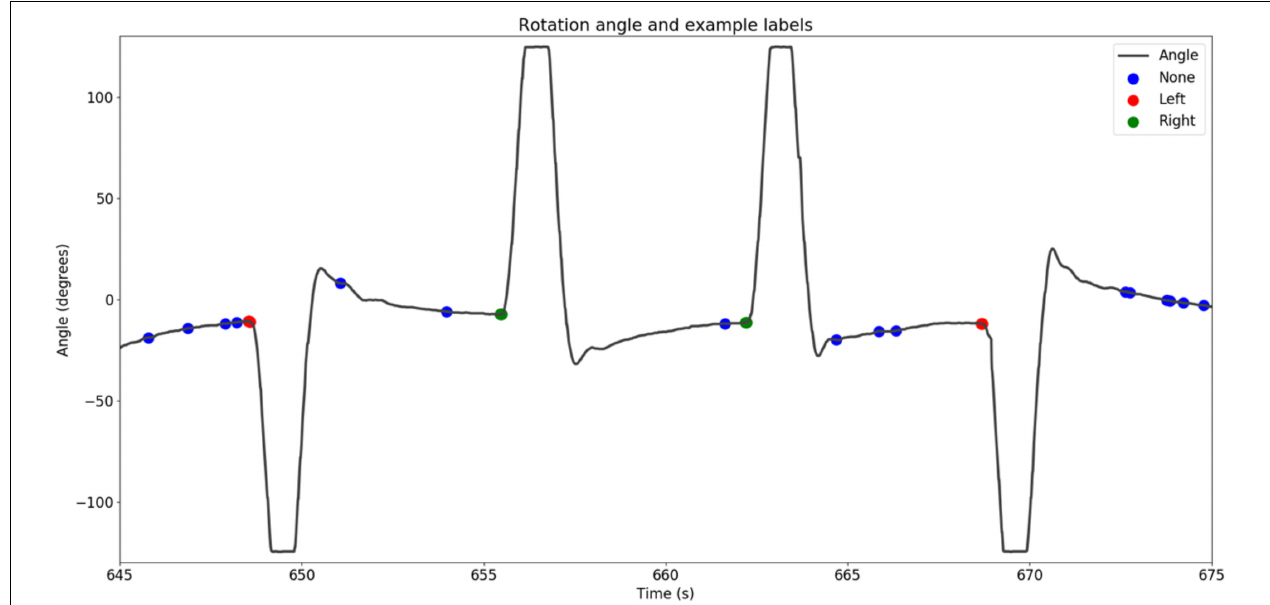
FIGURE 3 | Example IMU data showing the extracted movement onsets, as well as a random sample of moments in time that were considered to be no movement.